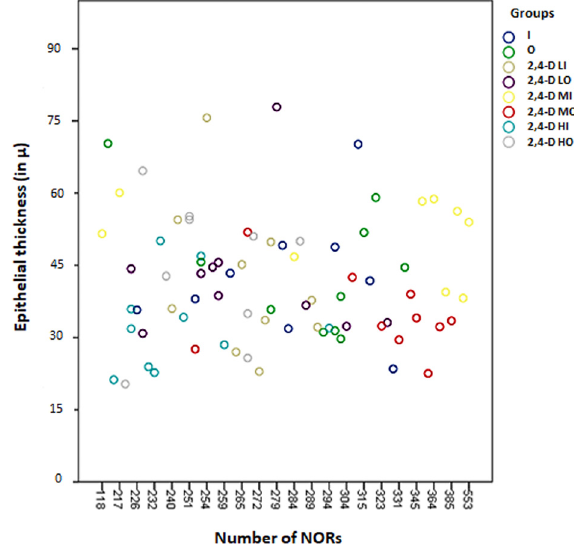
Figure 6. Correlation between total epithelial thickness (in m ) and the number of nucleoli-organizing regions (NORs) (per mm 2 ) in the esophageal epithelium in the experimental groups ( r = – 0.010; P=0.934) (Spearman ’ s nonparametric correlation). Groups: I: Inhalation control group; O: Oral control group; 2,4-D LI: Group exposed to low concentration of 2,4-dichlorophenoxyacetic acid (2,4-D) by inhalation; 2,4-D LO: Group exposed to low concen- tration of 2,4-D orally; 2,4-D MI: Group exposed to